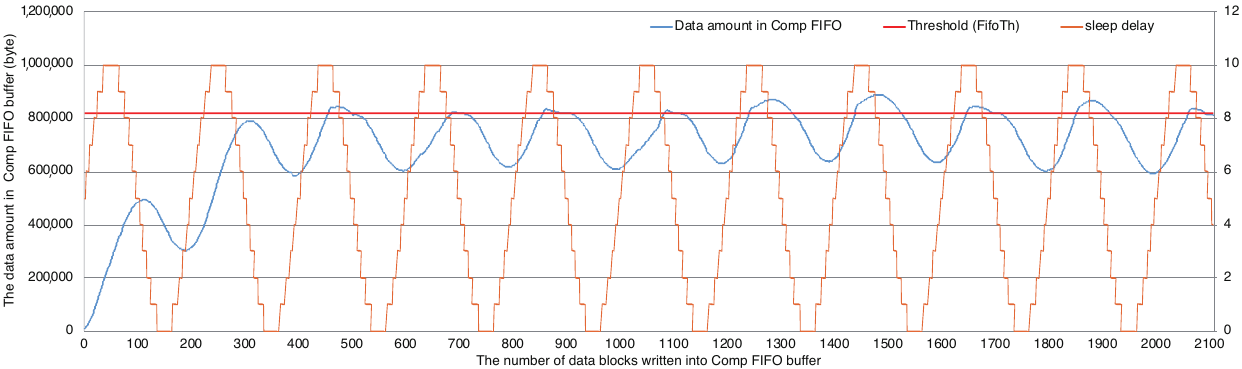
Figure 10. The data amount maintained in Comp FIFO and the communication overhead (delay) given during the